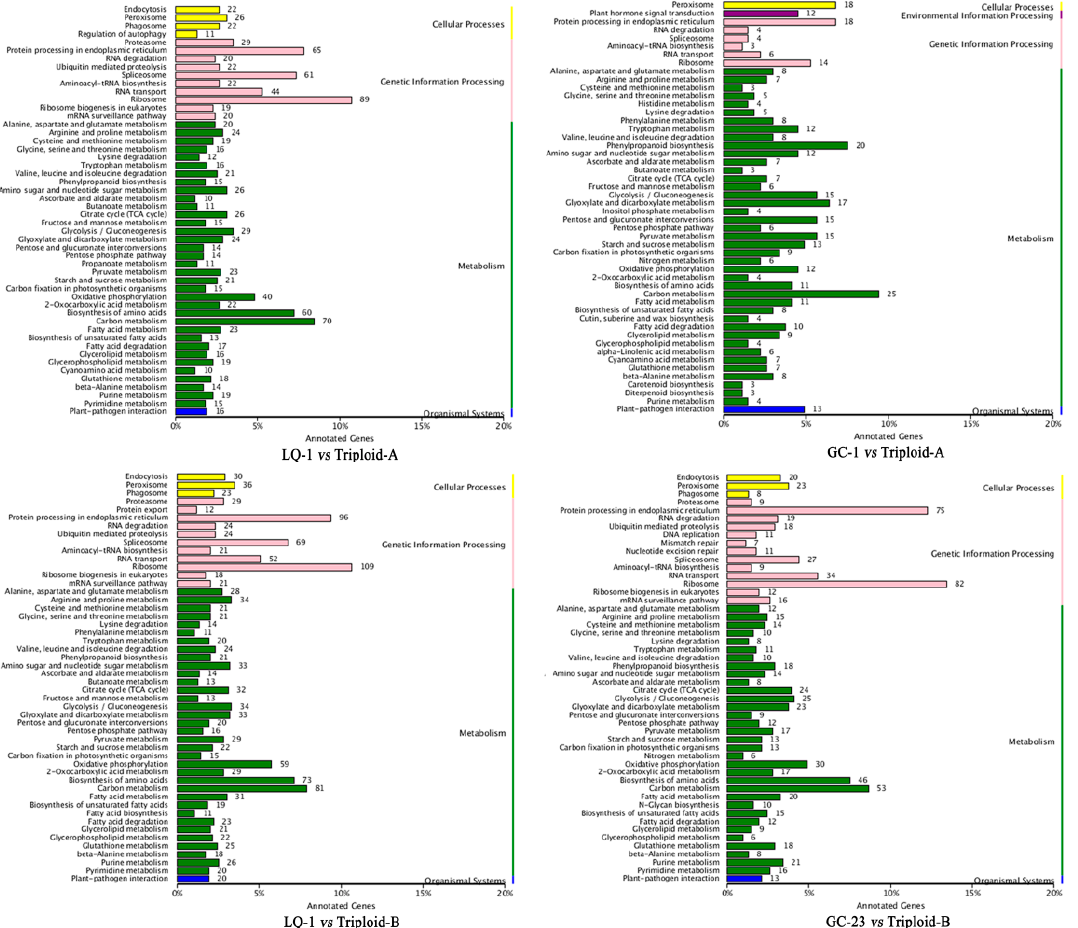
Figure 6. KEGG analyses of the DEGs in the different comparisons between the parent and